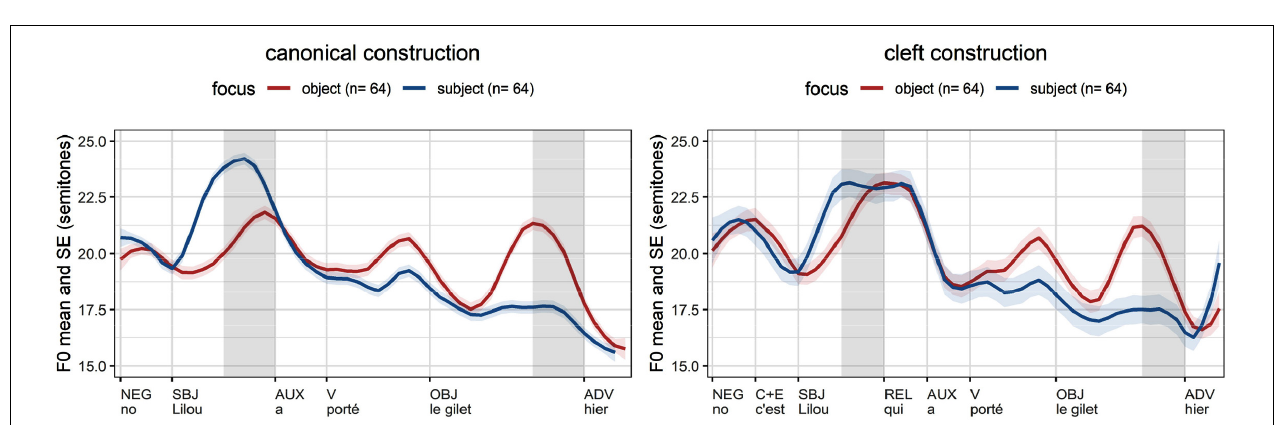
FIGURE 5 | Average f o measurements in French (time normalization based on five equal intervals per syllable; vertical lines: word edges; gray cells: areas of interest, stressed syllable of subject and object).